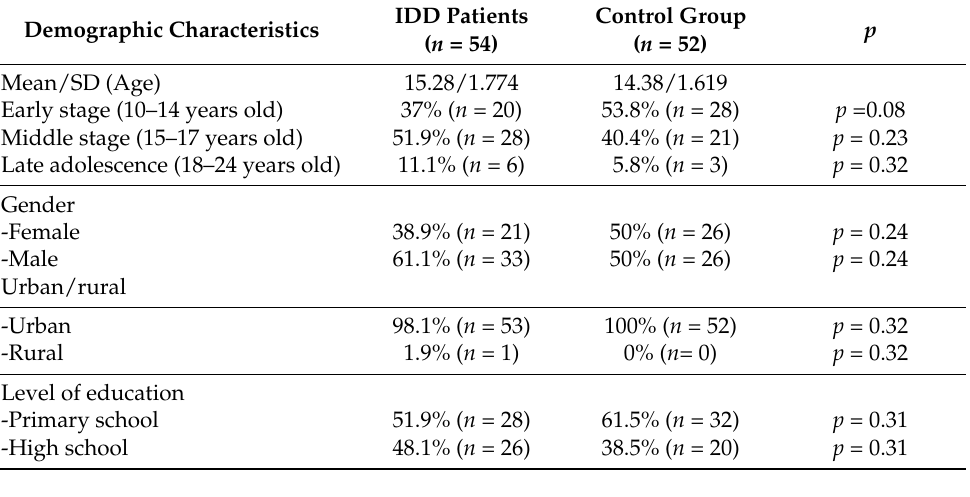
Table 1. Demographic characteristics of sample.